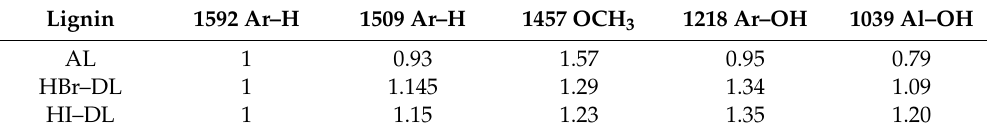
Table 1. FT-IR peak assignments and relative absorption values of AL and DL samples.